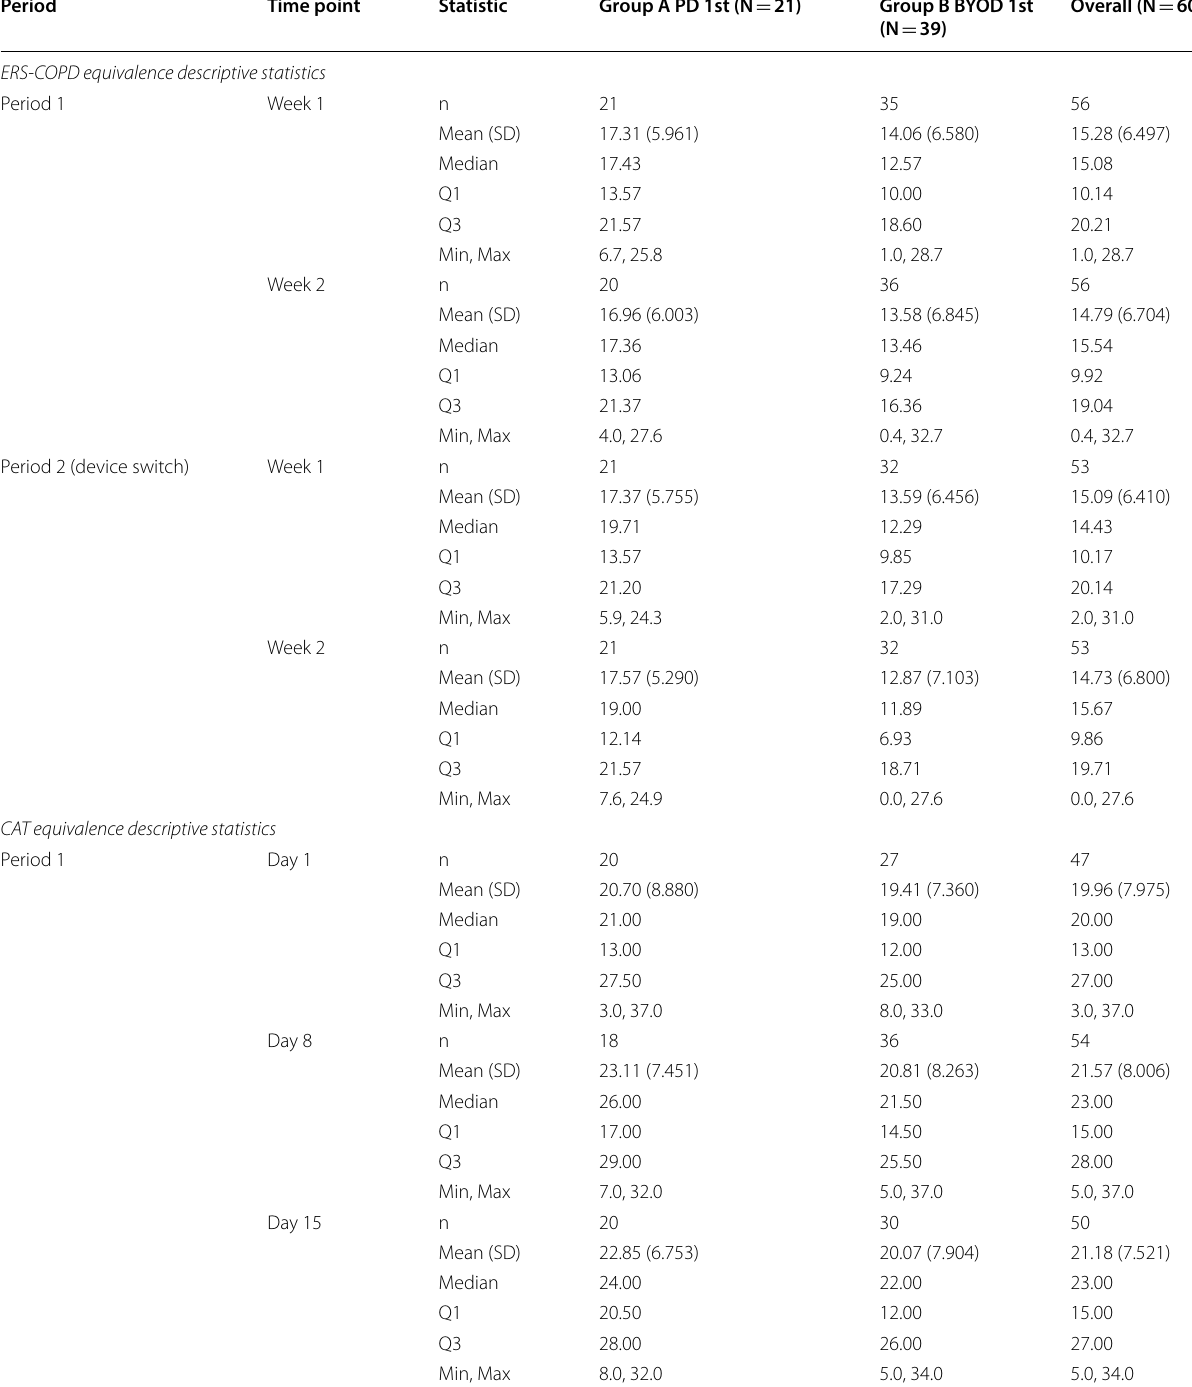
Table 2 ERS-COPD and CAT equivalence descriptive statistics